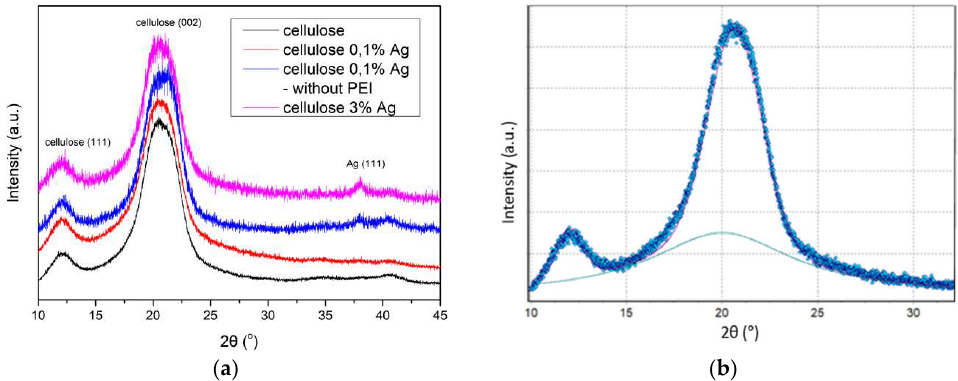
Figure 3. ( a ) XRD of cellulose fibers, ( b ) experimental curve with an amorphous area.